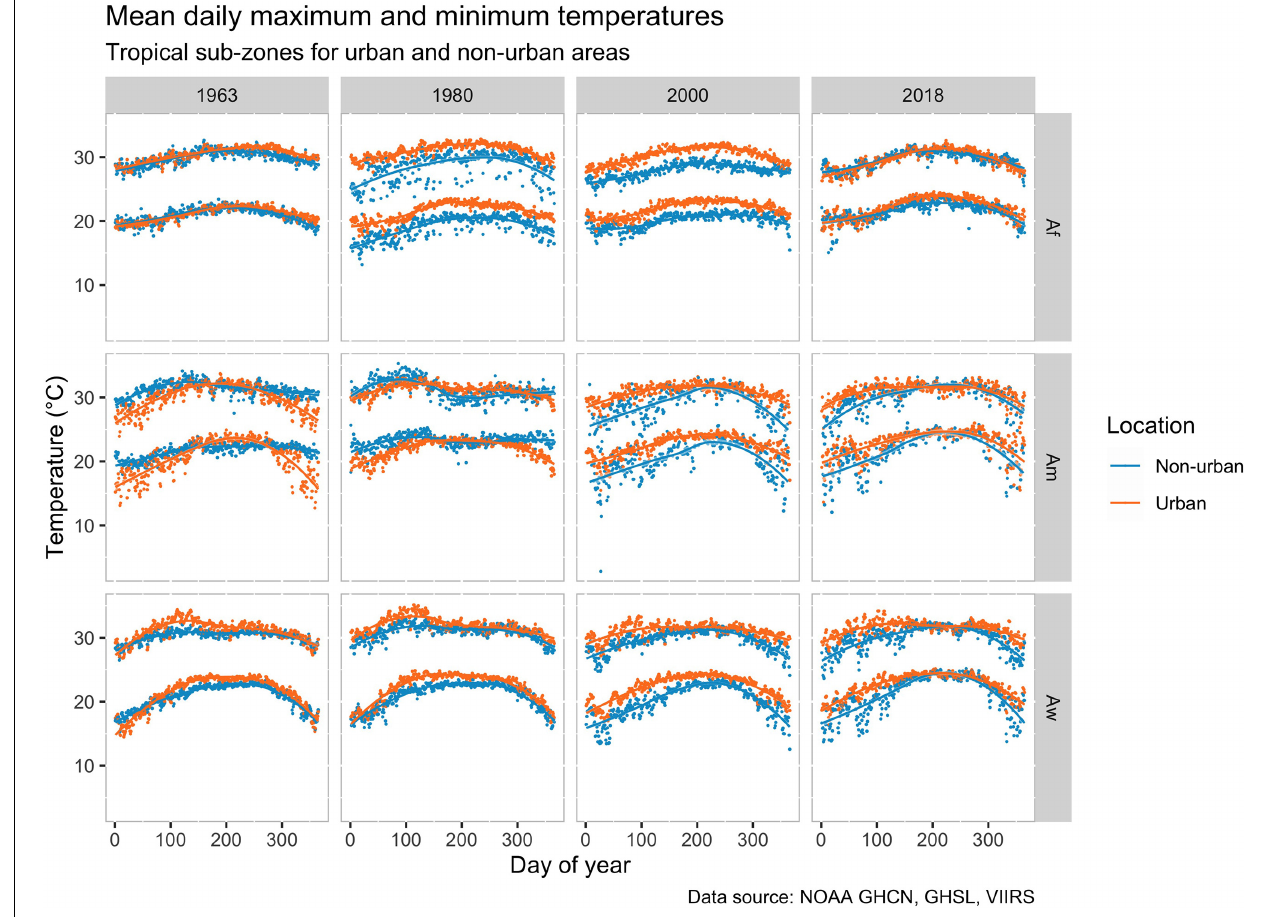
FIGURE 6 | Change in mean daily maximum and minimum temperatures across 55 years in urban and non-urban areas by tropical zone. The higher points and curves on each mini-plot represent the maximum temperatures and the lower points and curves represent the minimum temperatures. Data source: NOAA,